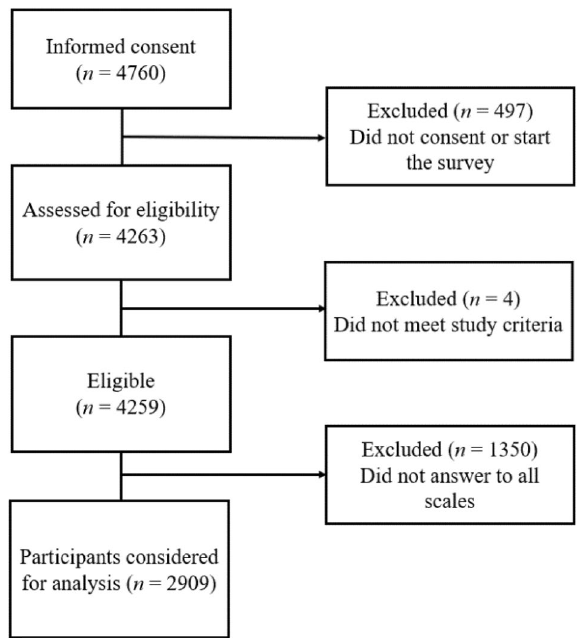
Figure 1. CONSORT flowchart of participants of the present